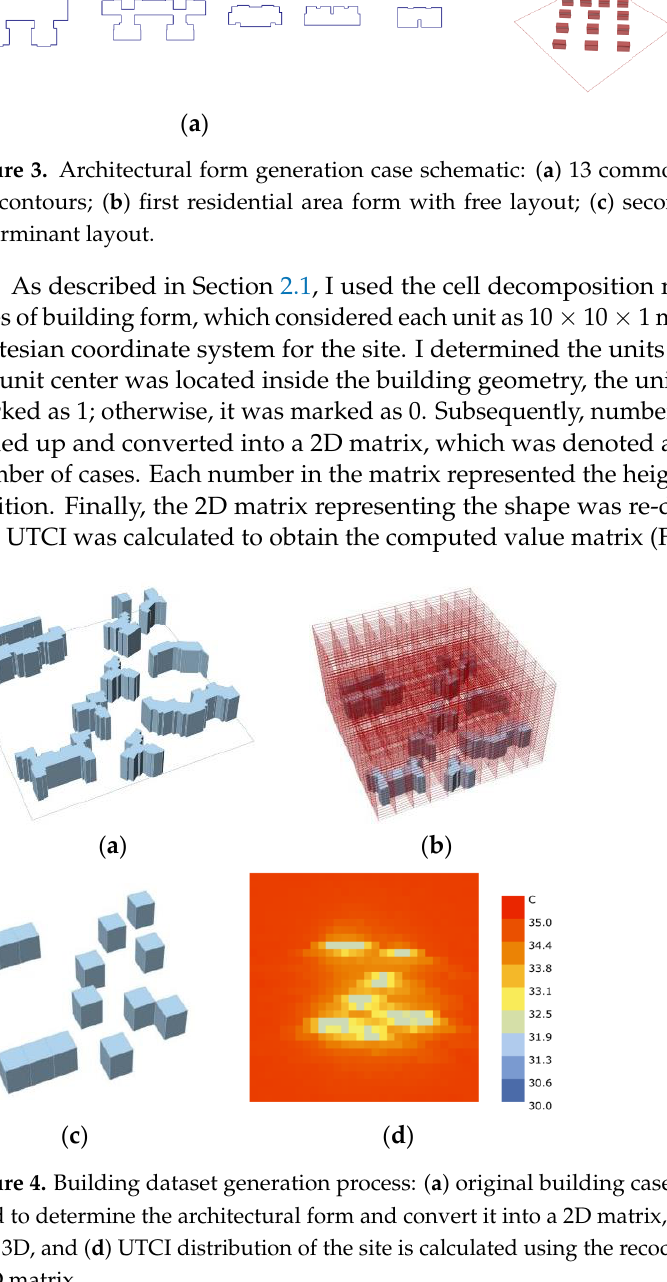
(Figure 3b) and determinant (Figure 3c). By randomly setting the building height, location, and orientation, the architectural forms of 2400 residential blocks were generated.